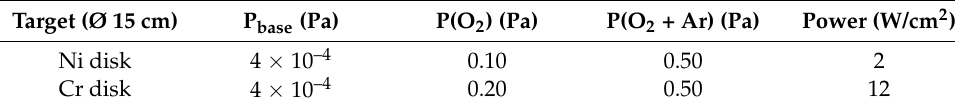
Table 1. Experimental conditions of sputtering